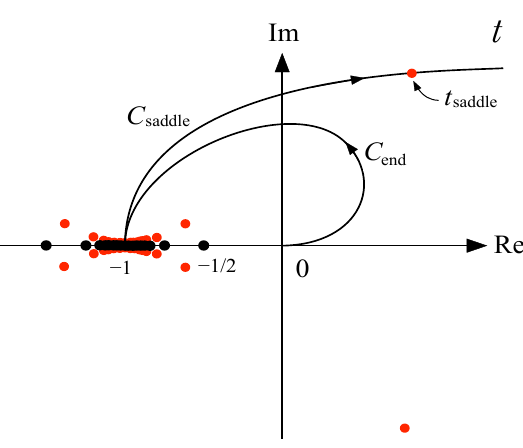
Figure 8 . Steepest descent contour for the ghost number zero tachyon with (cid:21) = (cid:0)j (cid:21) j e i(cid:18) and ( : 650 : : : ) (cid:25) < (cid:18) < (cid:25) . We plot the contour for (cid:12)nite (cid:11) so that the saddle point t saddle can be seen on the same scale as the singularities on the negative real